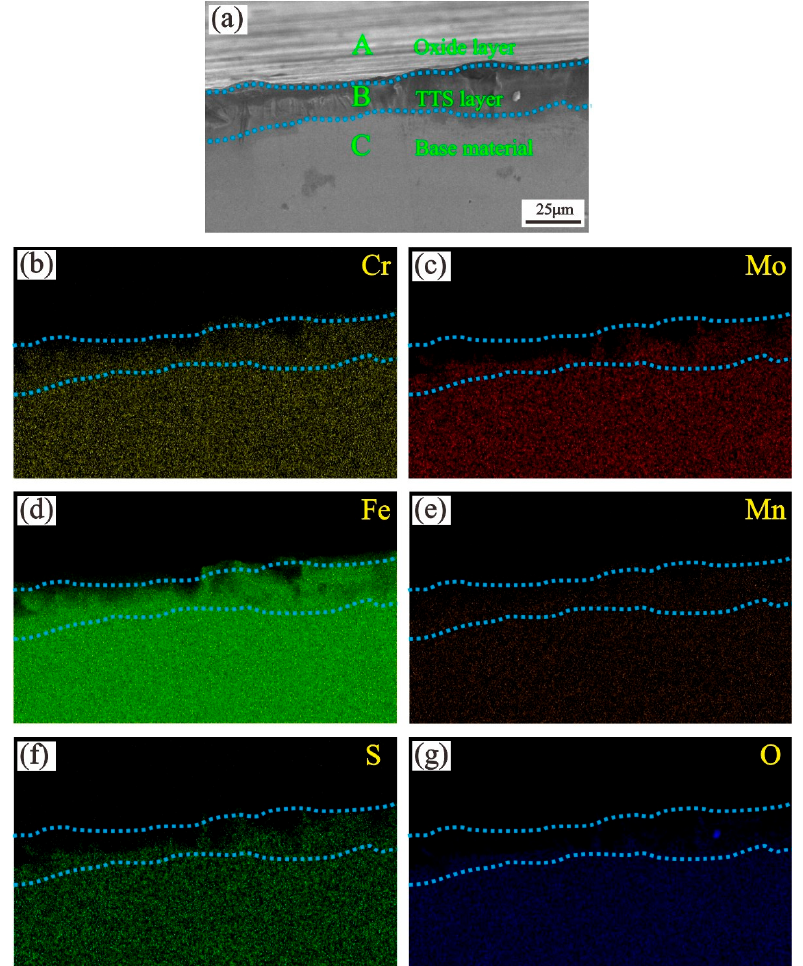
Figure 11. Morphologies of the cross section of a worn scar: T = 450 °C; F = 10 N; D = 50 μ m.